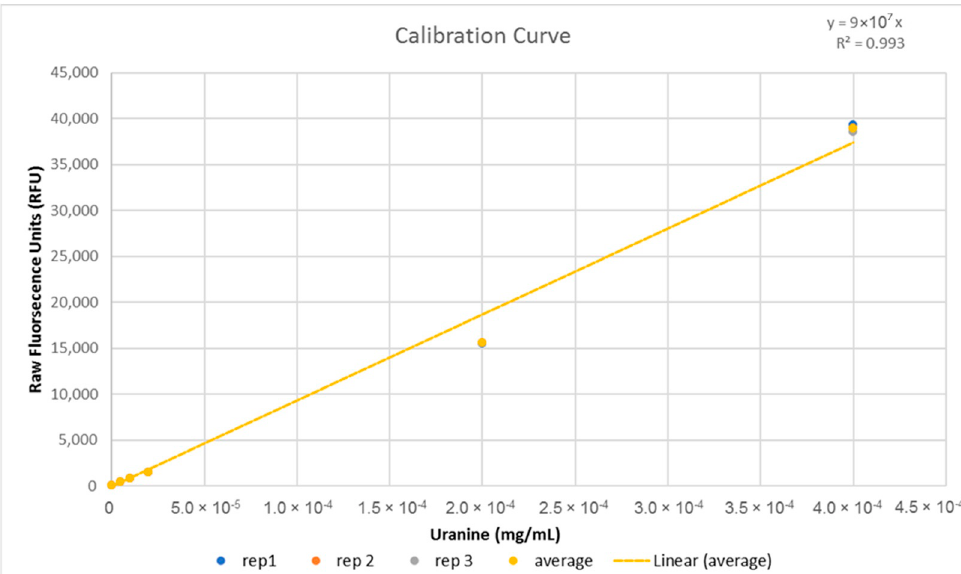
Figure A1. Calibration curve generated using a stock of 0.8% Uranine (8 mg/mL) in 10% sugar solution diluted into purified water and serially diluted to a suitable range. 2 mL was decanted and read from 10 mL of each concentration three times in the fluorometer to give raw fluorescence units and the average was used to generate the line of best fit. The equation and R 2 value of the curve is displayed on the upper right corner of the graph.